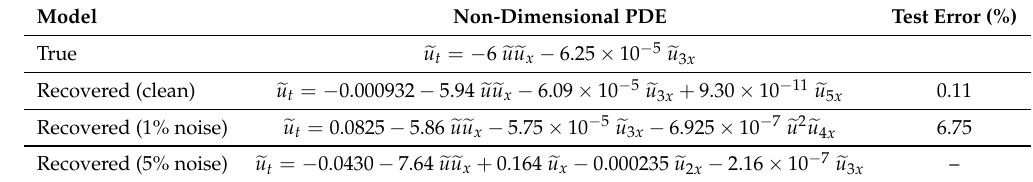
Figure 9. Predicted models with varied test error and complexity for KdV equation. Table 7. Identifying KdV equation using